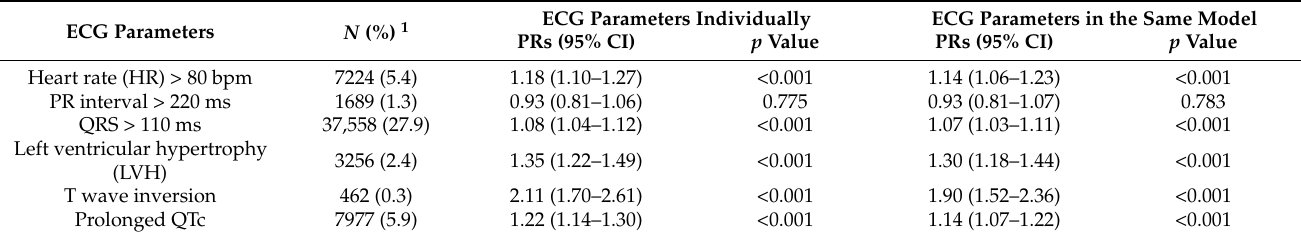
Table 2. Analysis of individual ECG parameters with prevalence of CAC.